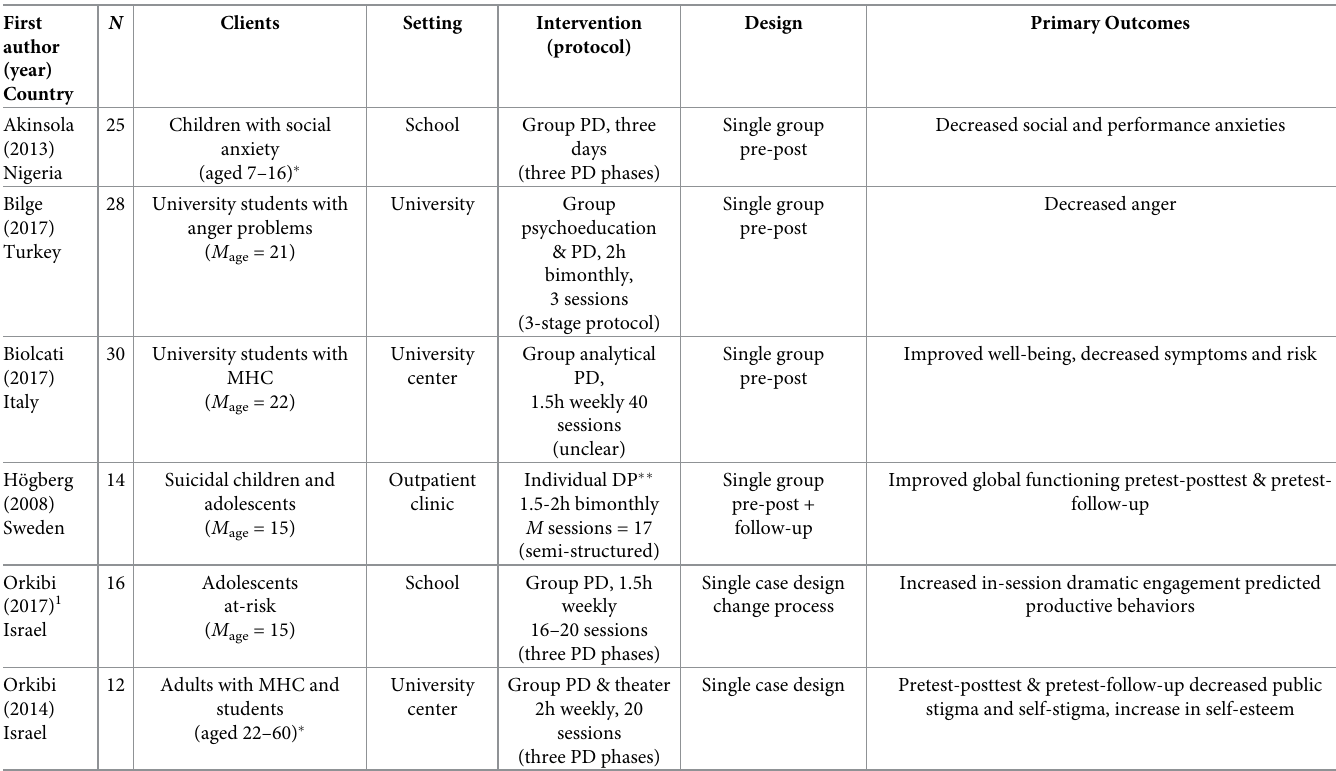
Table 3. Characteristics of quantitative single group